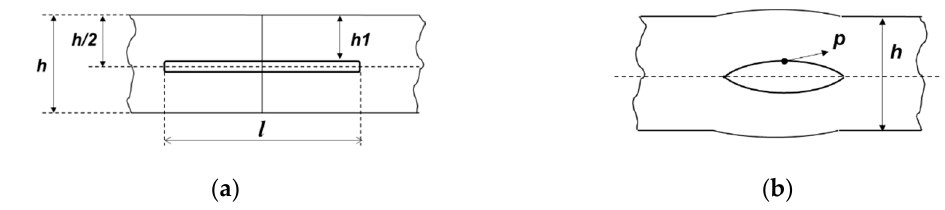
Figure 1. Scheme of the formation of a cavity: ( a ) Initial position of the notch before being subjected to an internal pressure load p ; ( b ) Opening of the notch under pressure.